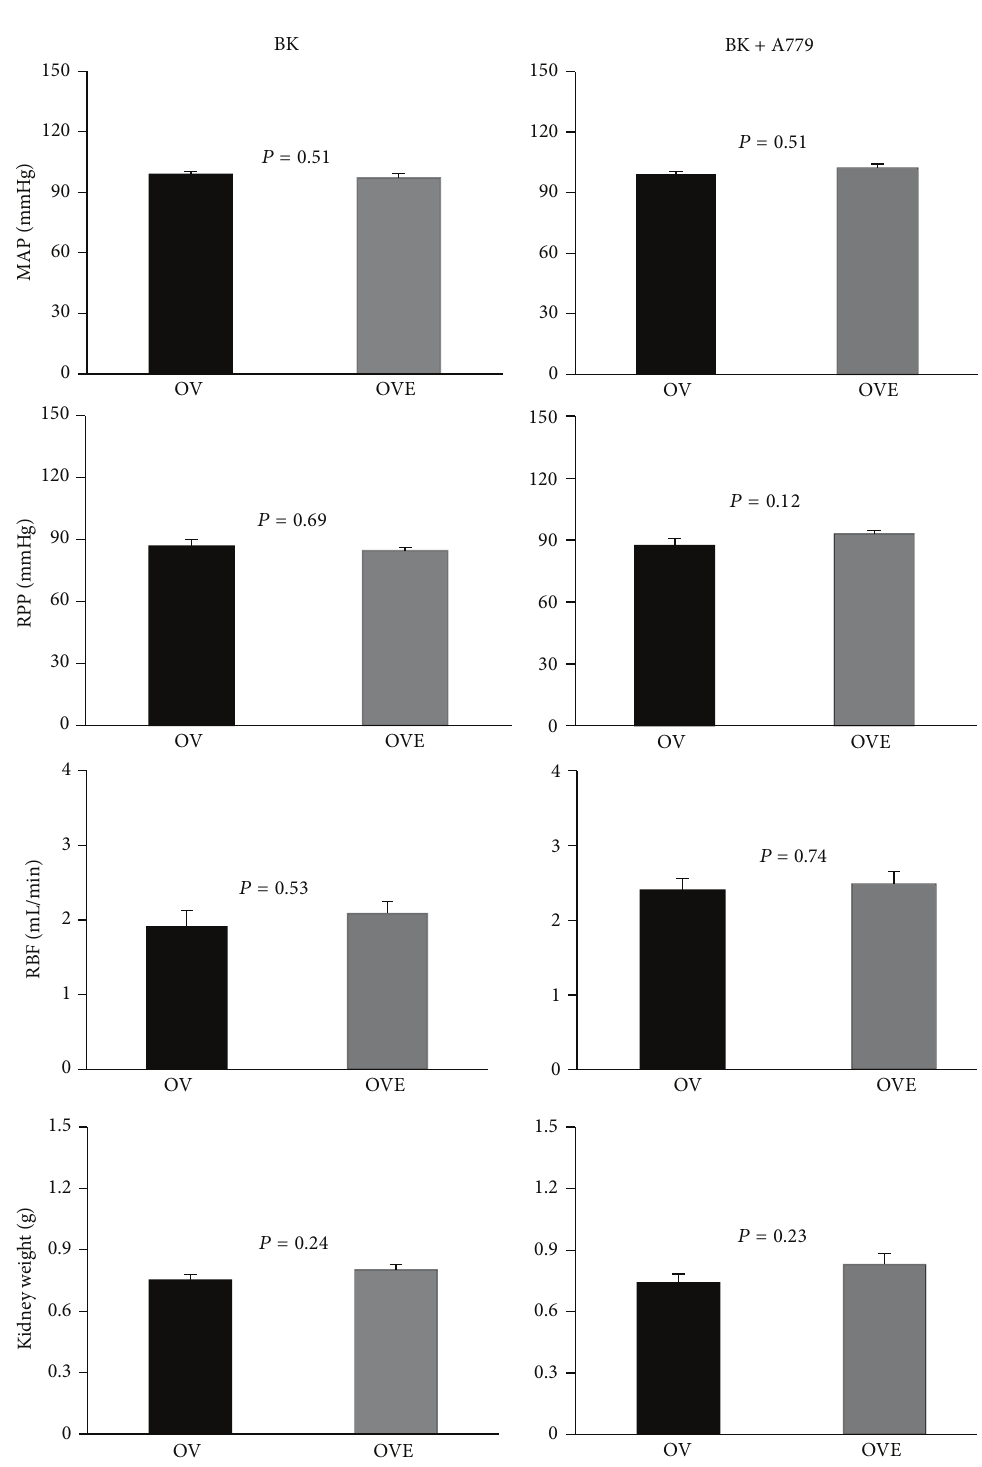
Figure 1: Baseline hemodynamic parameters in BK and BK + A779 groups in ovariectomized untreated and ovariectomized estradiol-treated rats. Data are presented as mean ± SEM. MAP, mean arterial pressure; RPP, renal perfusion pressure; RVR, renal vascular resistance; RBF, renal blood flow per gram kidney weight. There were no significant differences between the